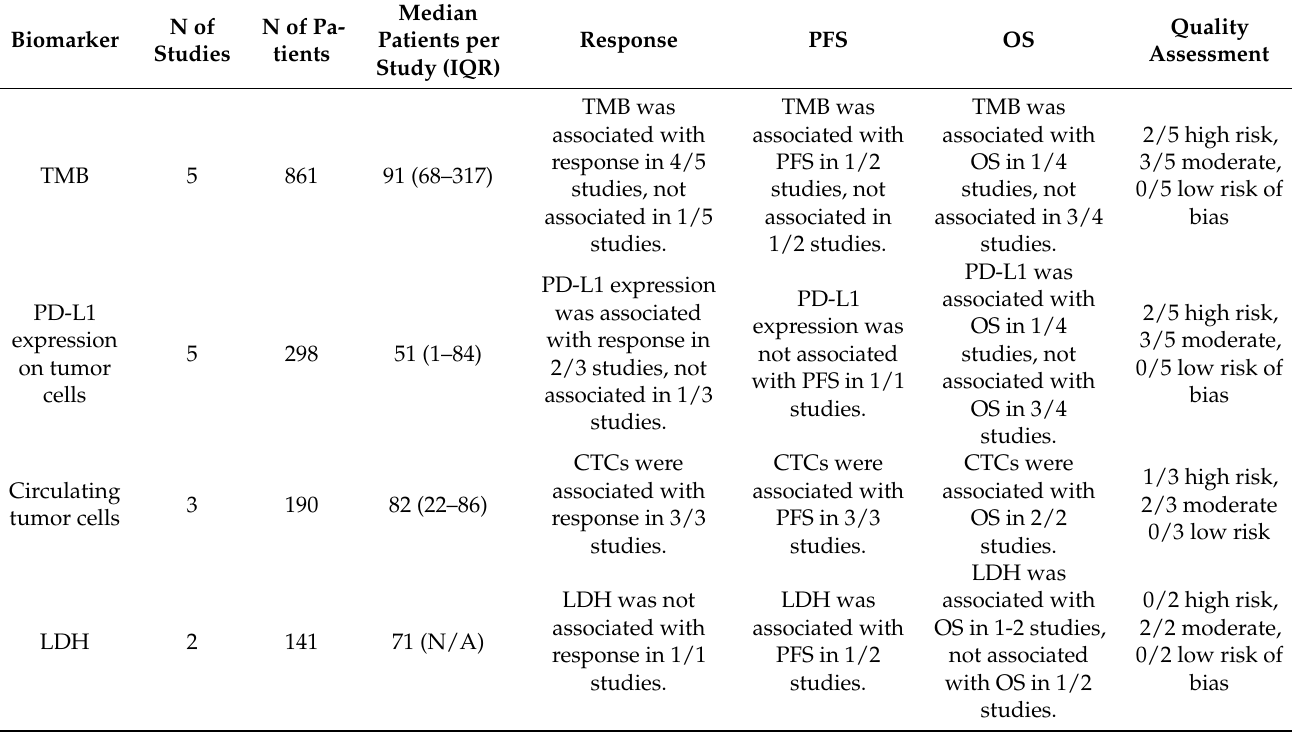
Table 4. Summary of most important biomarkers that were studied for mixed cohorts and assessed risk of bias per article.